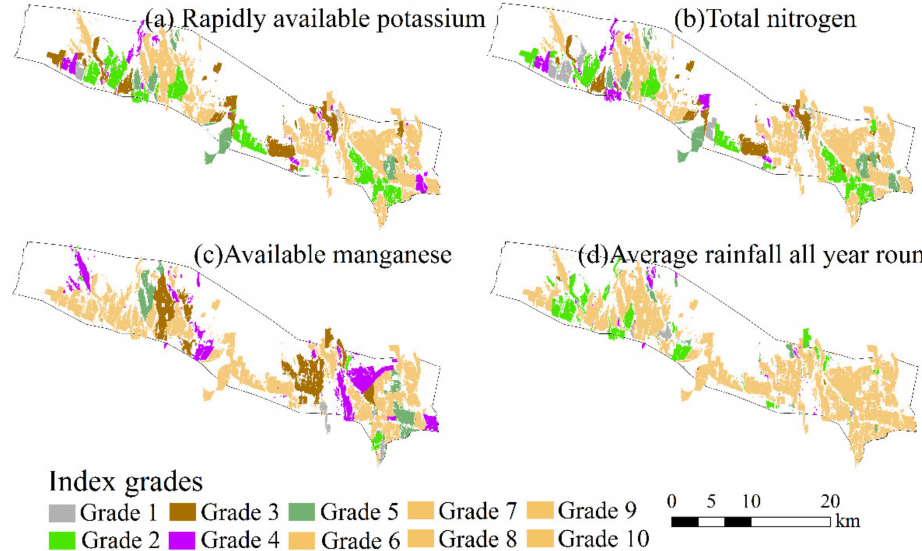
Figure 8. Spatial distribution of the influential factors at the middle part of the diluvial fan. ( a ) Rapidly available potassium, ( b ) Total nitrogen, ( c ) Available manganese, and ( d ) Average rainfall all year